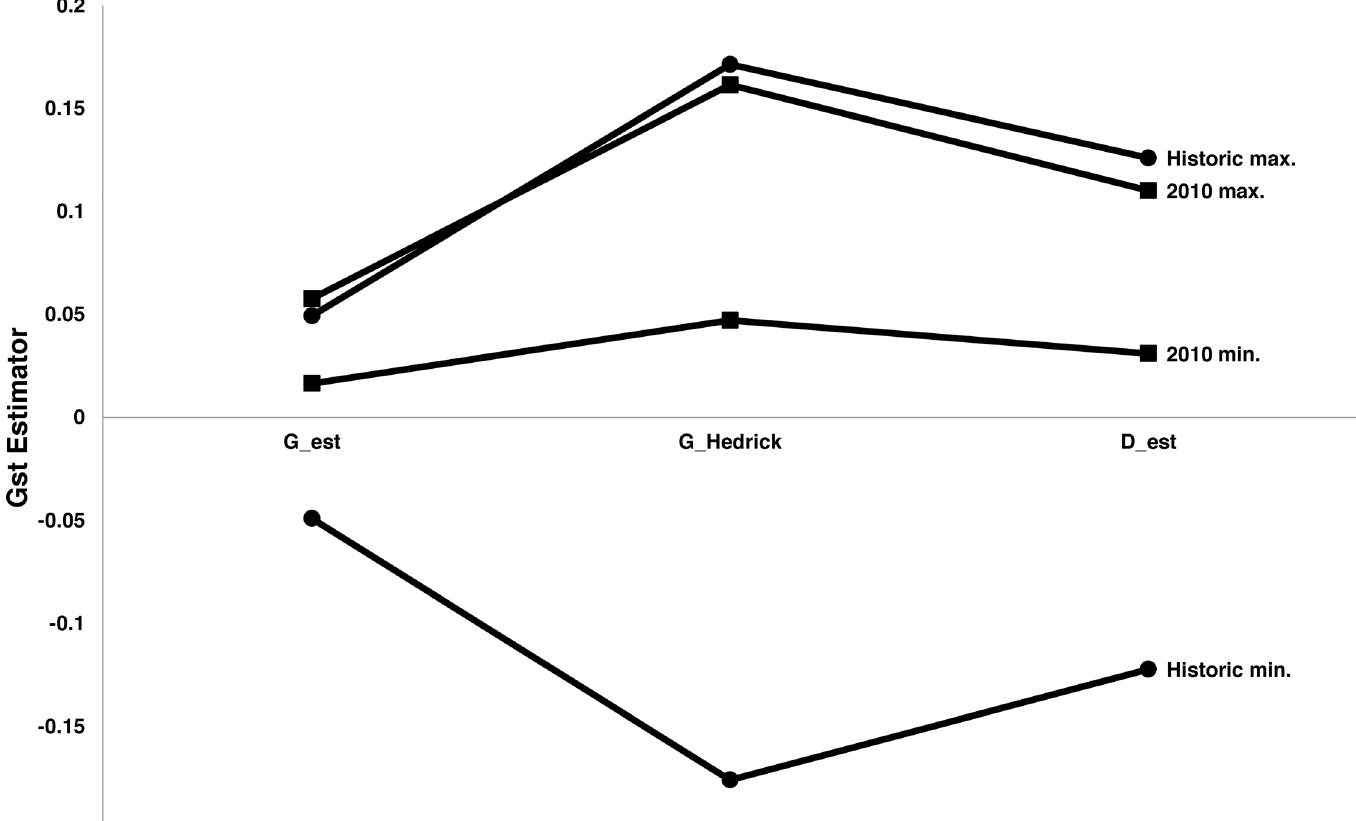
Fig 4. Estimates of G st analog 95% confidence intervals from SMOGD [29] for historic and 2010 populations of L . tumana .